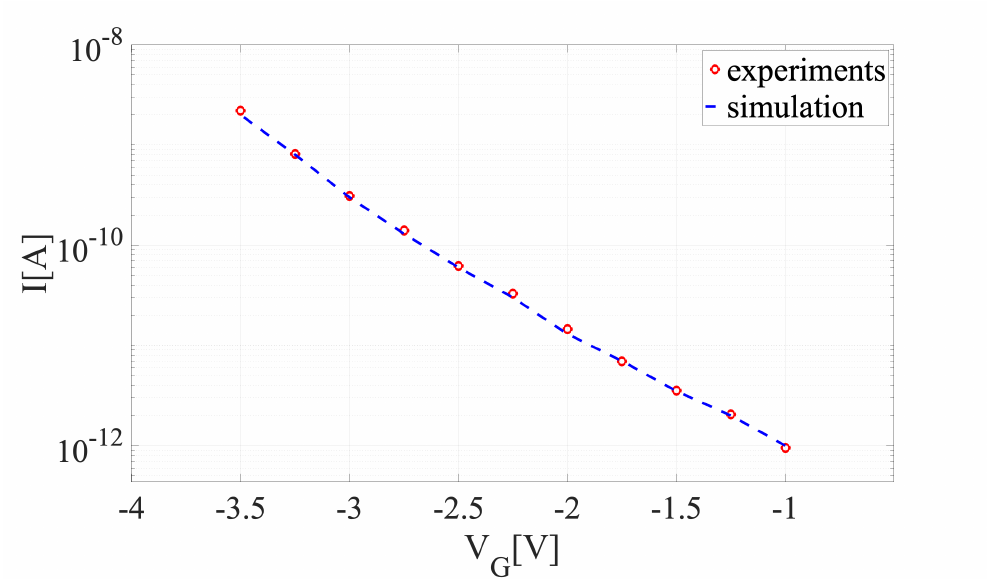
Figure 6. A comparison between the experimental [20] and simulation current.